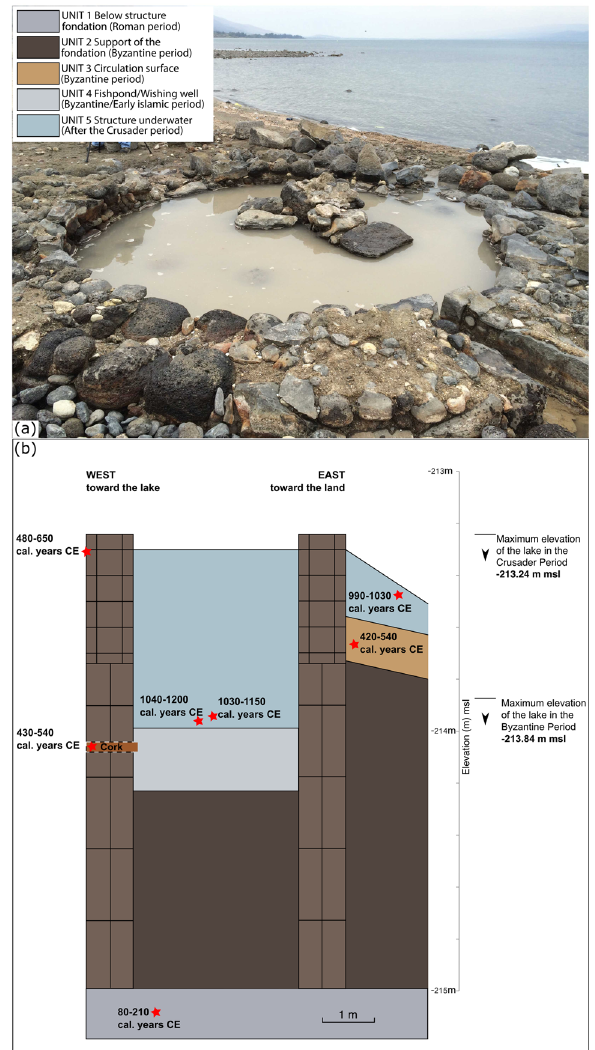
Figure 4. The fishpond/wishing well (Area C). ( a ) Structure viewed from the North with the lake in the back (Photo: Michal Artzy) and ( b ) Lake-level index points obtained from the study of the fishpond. The red stars represent the location of the samples dated by radiocarbon. The index points are compared and contrasted with data originating from other sites in Fig.